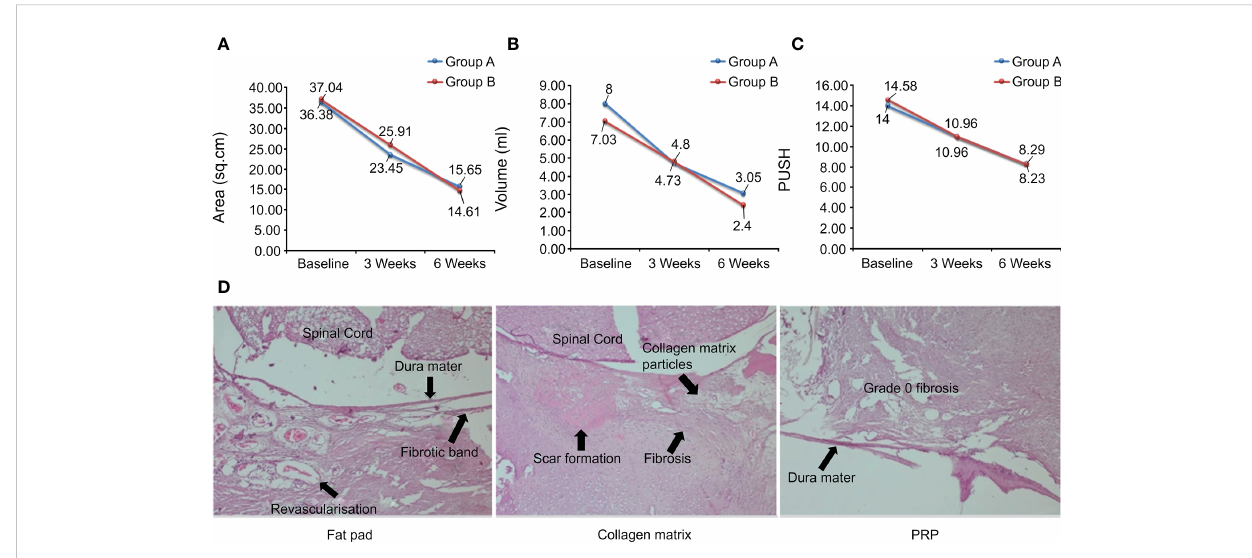
FIGURE 7 (A-C) Ulcer area, ulcer volume, and PUSH score over time. (D) Scar and fi brotic tissue staining in different groups. Reproduced with permission from (130,